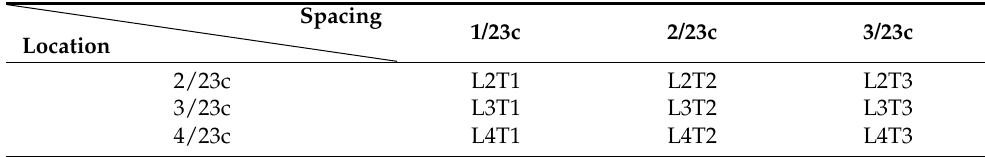
Table 1. Design scheme of parallel grooves.